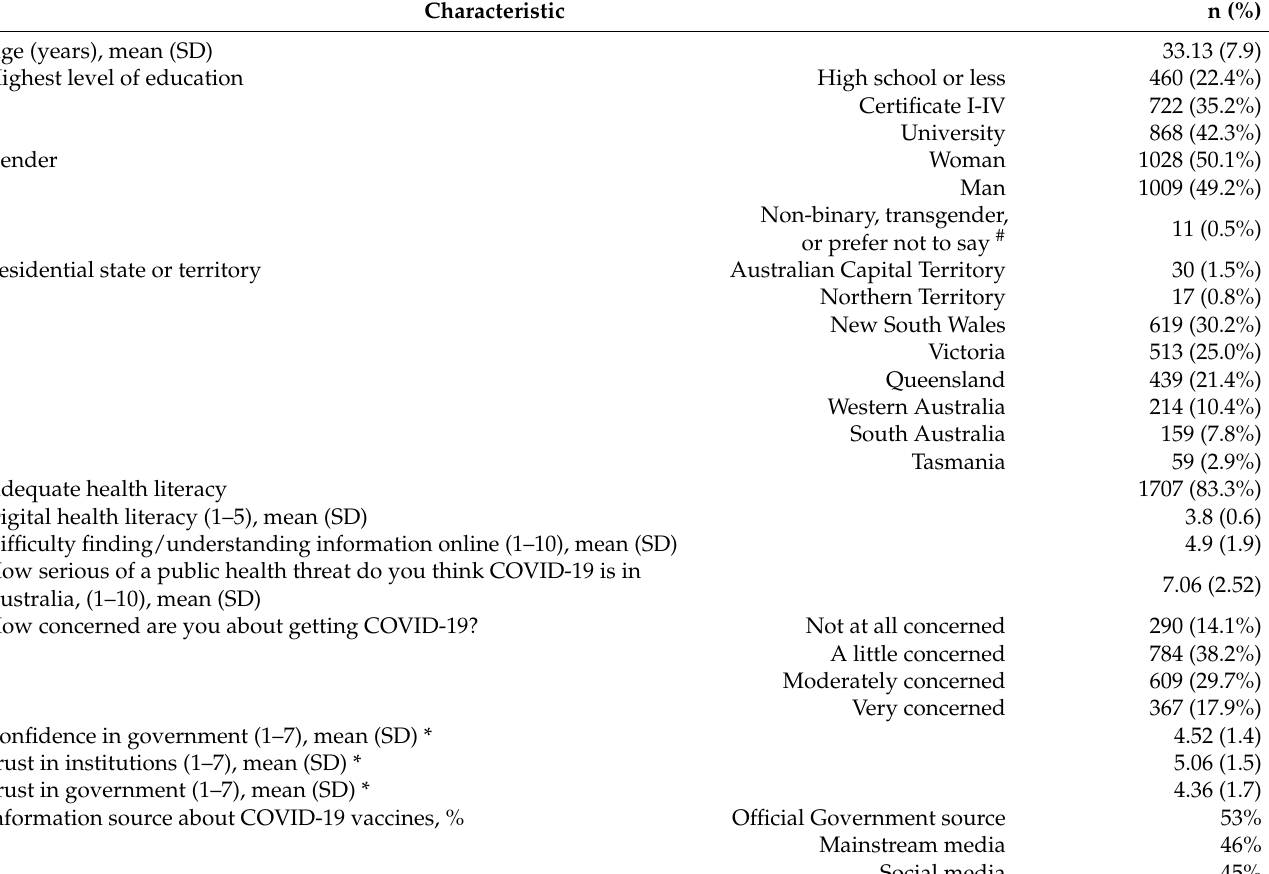
Table 2. Sample characteristics (N = 2050). Values are shown as n (%) unless otherwise indicated.